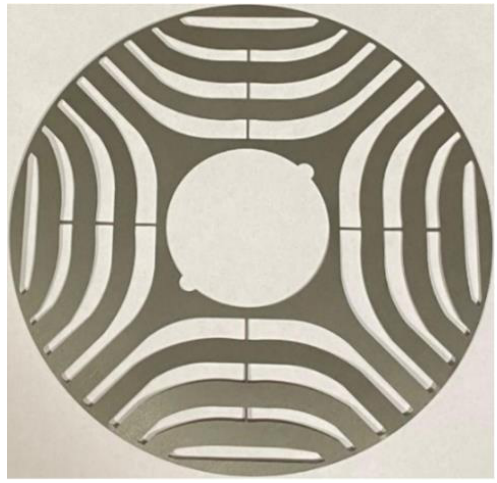
Figure 6. The view of a processed rotor sheet. The manufactured novel SynRM, the driver, and test system utilized are shown in Figure 7.